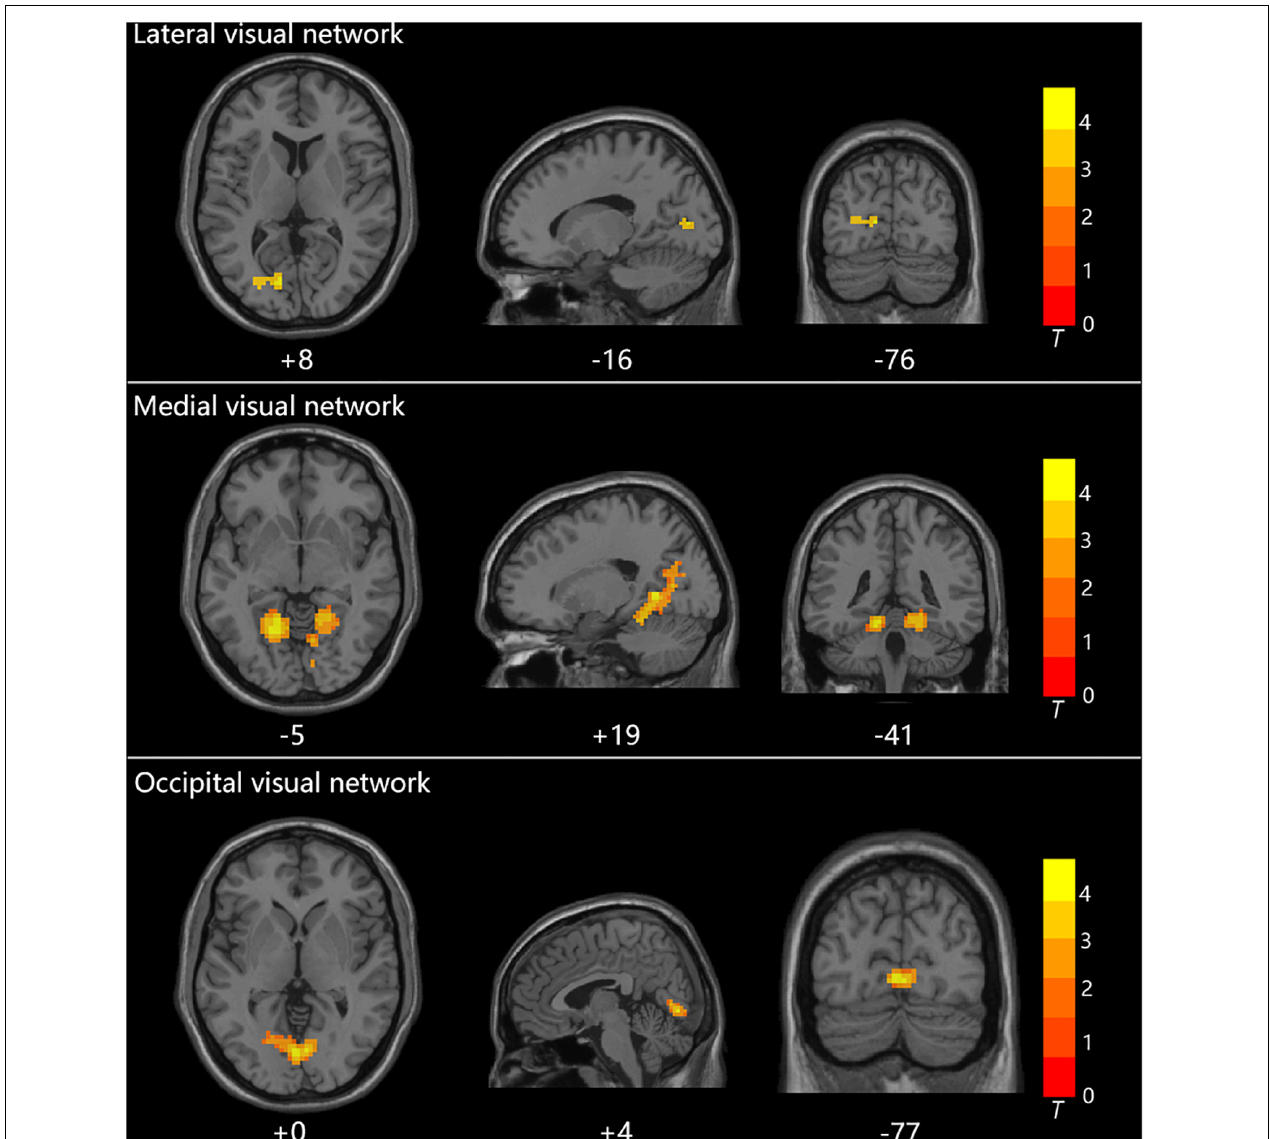
FIGURE 2 | The three visual networks and increased functional connectivities within the networks in healthy controls as compared with high-tension glaucoma patients.